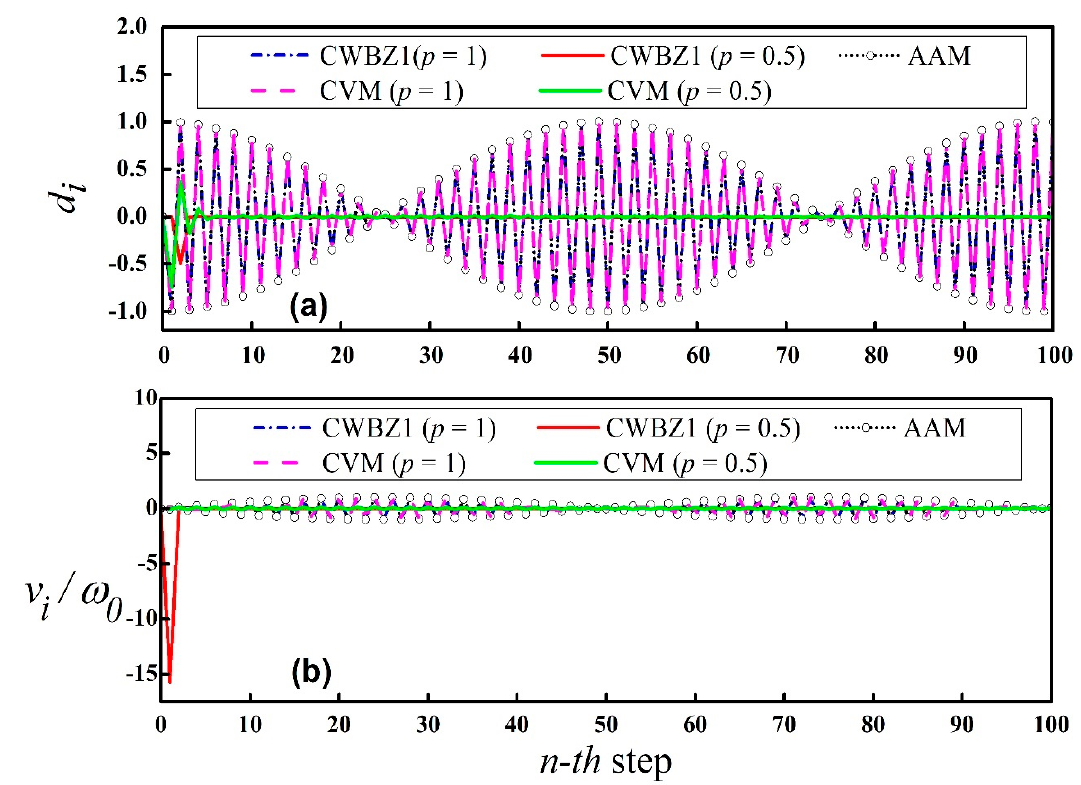
Figure 5. Comparison of the overshoot response of CVM for the first initial conditions.